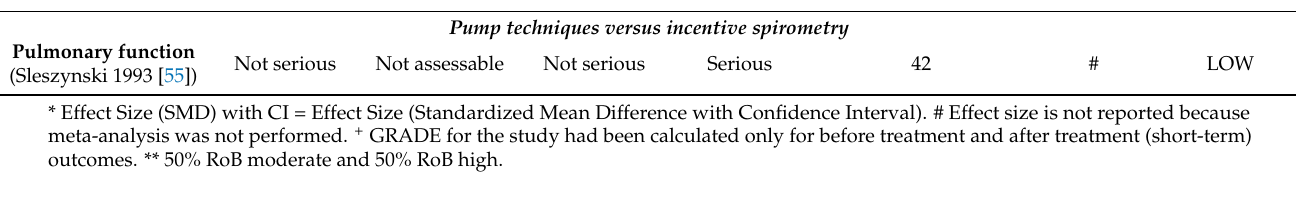
Table 6. GRADE evaluation of the studies on pompages: quality of evidence and strength of recommendations.